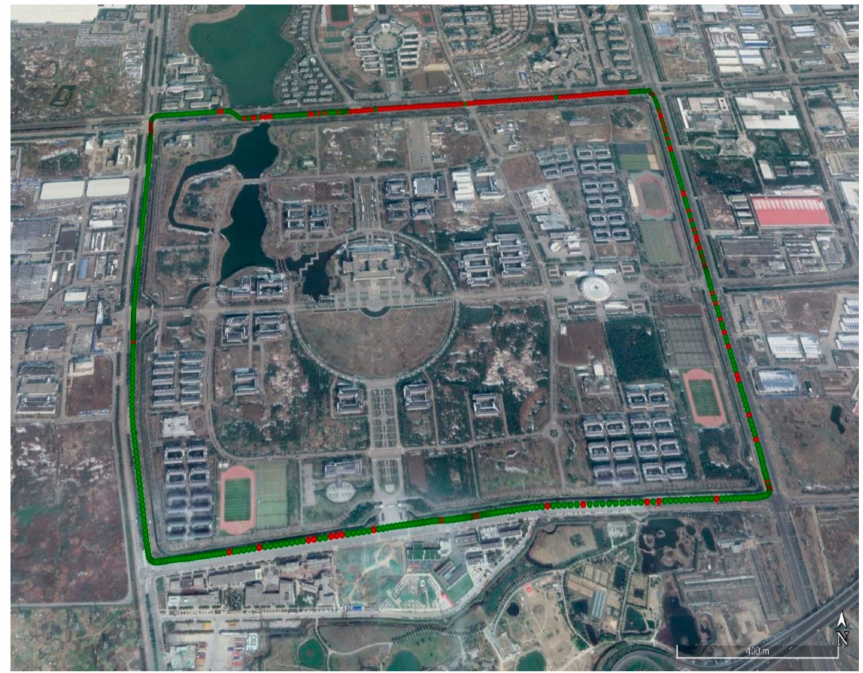
Figure 3. The vehicular trajectory of the experiment (Green: reference result; red: our result).